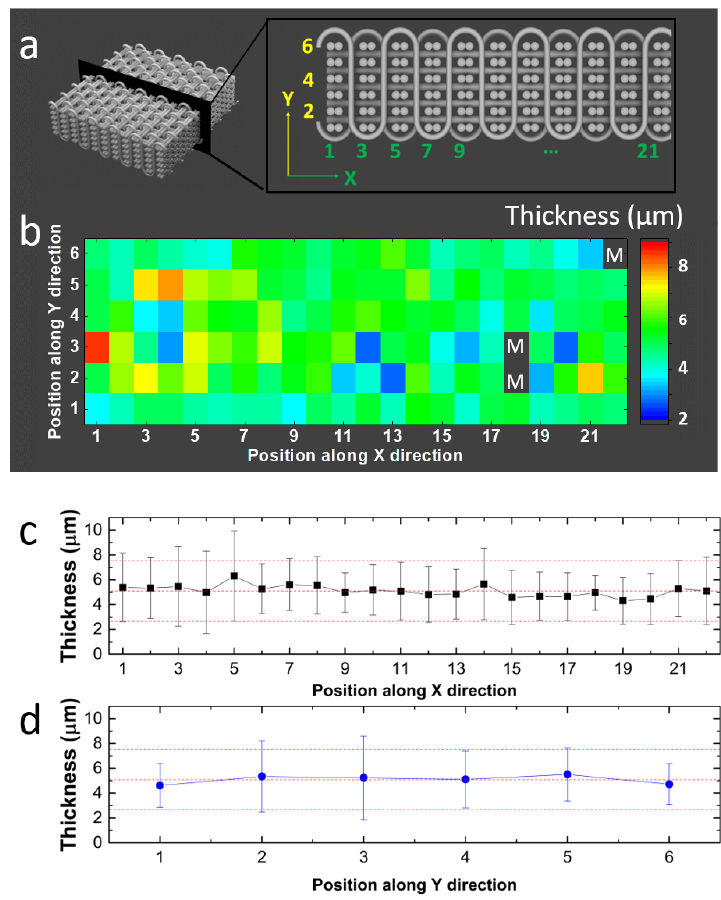
Figure 7. Coating thickness distribution on fill wires. ( a ) A schematic of a cross-sectional slice; ( b ) a coating thickness heatmap for the cross-section showing average coating thicknesses on individual fill wires as a function of location. M = missing wires; ( c ) coating thickness plotted along the horizontal direction (mean ± SD); ( d ) coating thickness plotted along the vertical direction. Red dashed line = global average and one standard deviation of all HAp coating thickness measurements (mean ± SD).